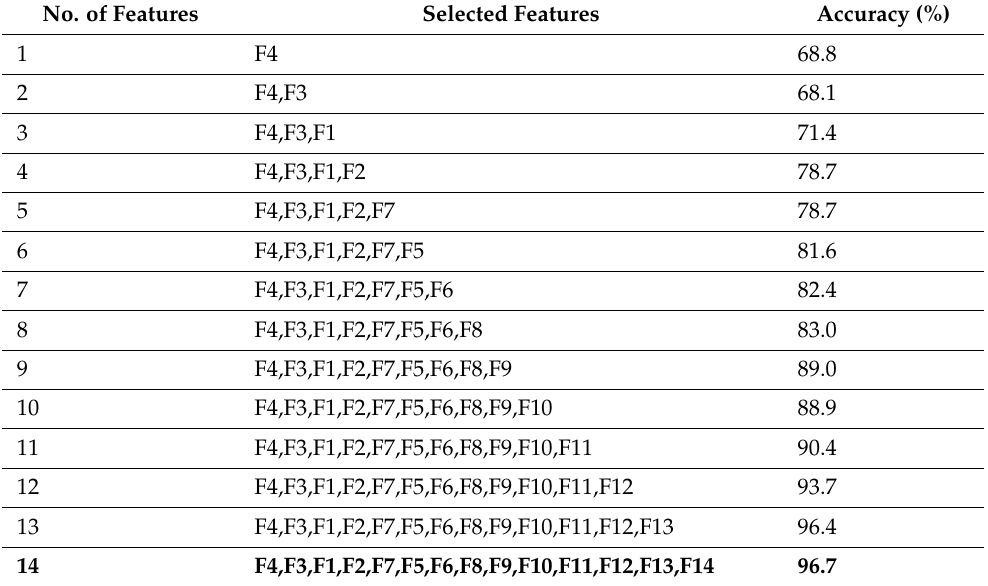
Table 8. Performance of fault detection using SFS with RF (five-fold